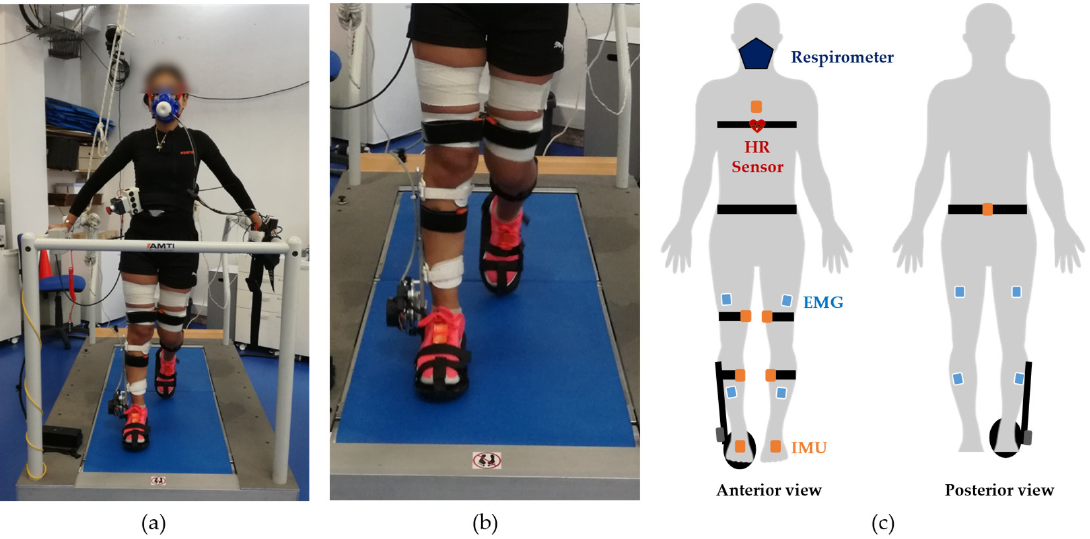
Figure 1. Representation of the setup’s instrumentation on the human body: ( a ) example of a participant during an assisted walking trial, while wearing all sensor setup (kinematic, EMG, and HR sensors and the respirometer); ( b ) zoomed-in view of the ankle-foot orthosis from the H2-Exoskeleton during the walking trial; and ( c ) schematic illustrating the IMUs placement on sternum , pelvis, upper leg and lower leg; the EMG sensors on the vastus lateralis , bicep femoris , tibialis anterior , and gastrocnemius lateralis muscles; the Polar H10 heart rate sensor at the chest; the respirometer, covering the user’s facial respiratory ways; and the ankle-foot orthosis fixed on the shank and foot segments of the right lower limb.